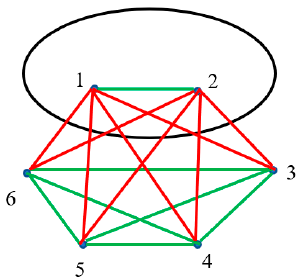
Figure 4. Black solid line depicts the Jordan curve dividing the plane into the interior and exterior regions (separated by the solid black line). Points labeled “1” and “2” are located within the interior region, and points “3”, “4”, “5” and “6” are located in the exterior region. Red edges connect points located in different regions; green edges connect points located in the same region. Triangles “456”, “345”, “356” and “346” are monochromatic.